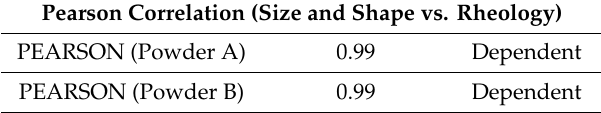
Table 6. Pearson correlation calculation examining the dependency of rheological data on particle size and shape for powders A and B.